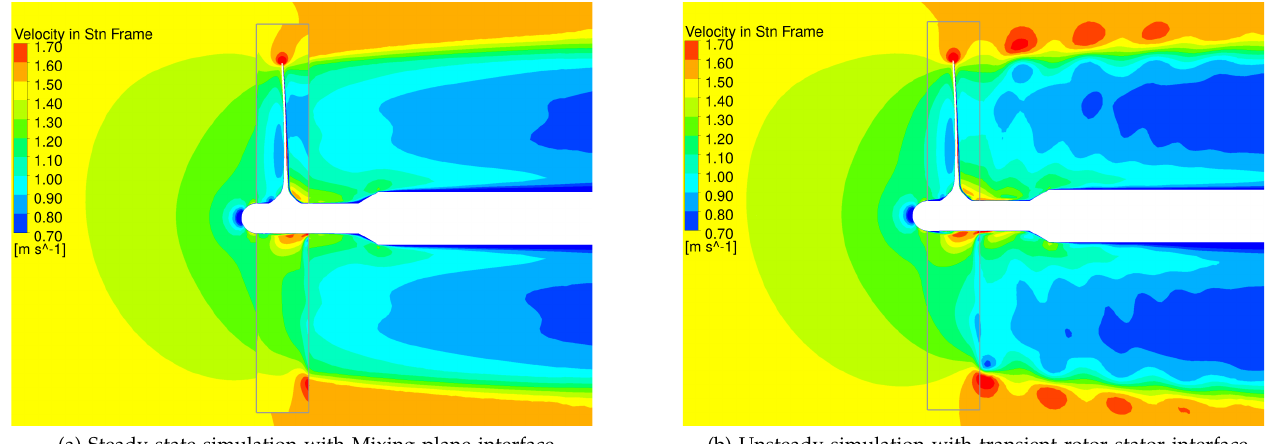
Fig. 9. Contour plot of absolute velocity in stationary frame around the second turbine. Interfaces depicted as grey lines. Simulation r/D = 1 . 4 .